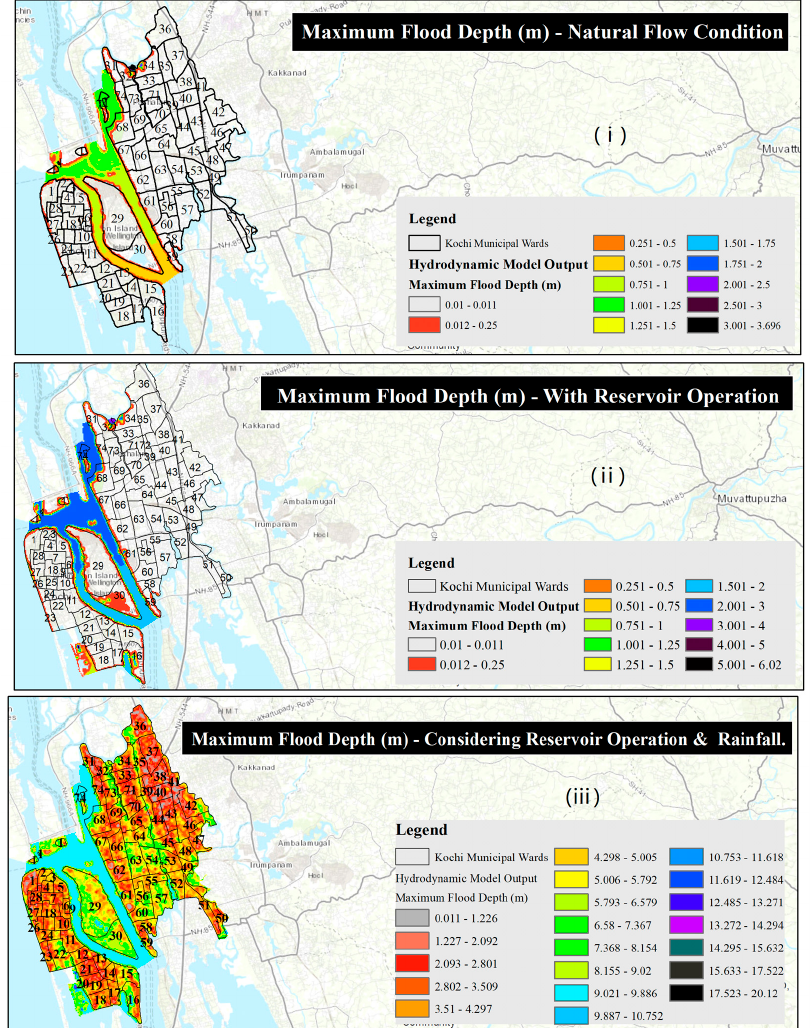
Figure 14. Comparison of Kochi City Maximum Flood Depth at three Different Scenarios, i.e., ( i ) Natural Flow Condition, ( ii ) With Reservoir Operation, and ( iii ) Considering Reservoir and Rainfall Both.